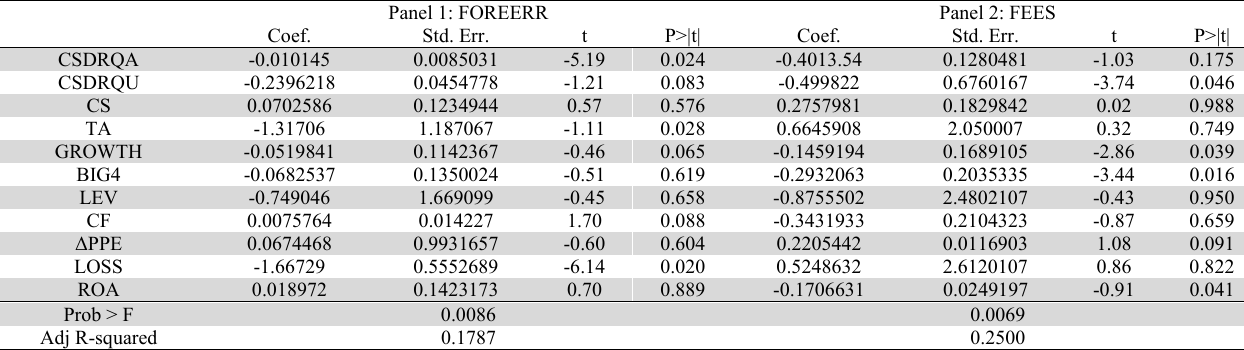
Regression results Panel 1: FOREERR Panel 2: FEES Coef. Std.